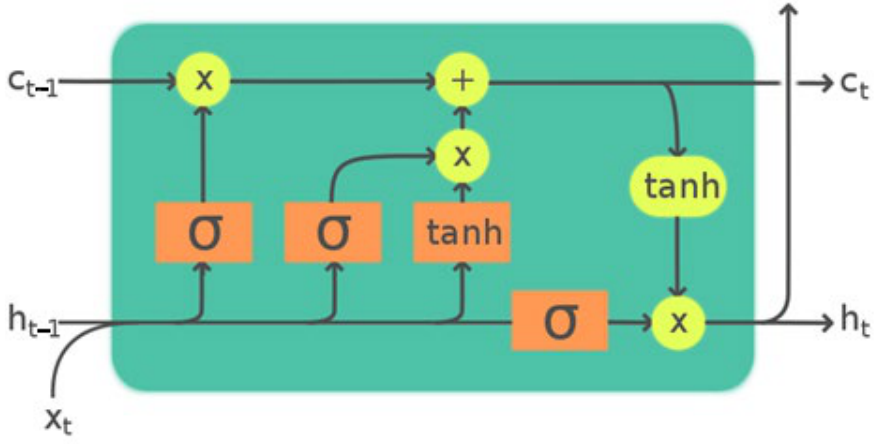
Figure 1. The LSTM architecture [39].